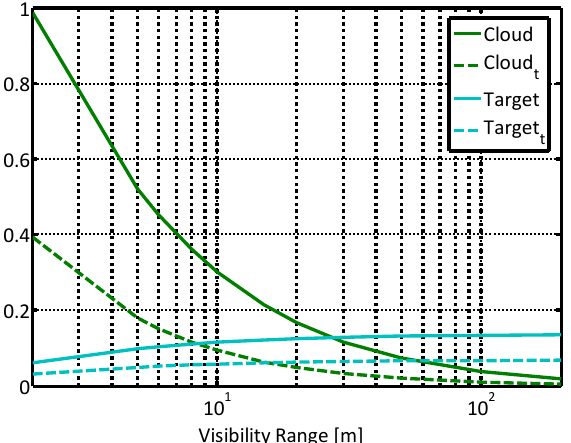
Figure 4. Calculated path integrated single scattering and target reflected power as a function of visibility, inside a “cloud-like” atmosphere, for un-polarized and polarized (marked by t ) signals. Target location is 3 m from the sensor.